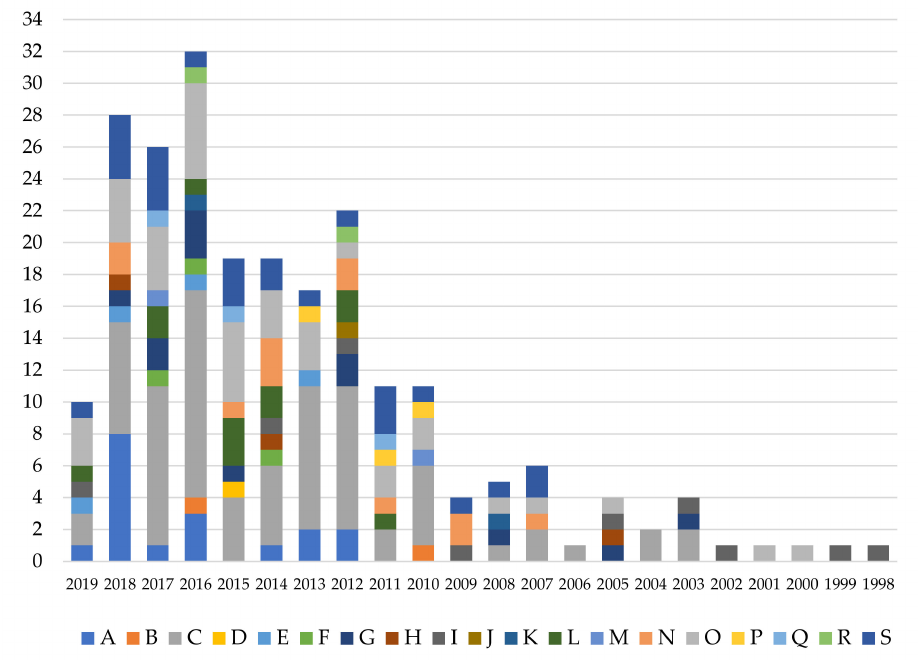
Figure 7. Number of studies classified by knowledge and year categories: Agriculture, forestry and fishing ( A ); Mining and quarrying ( B ); Manufacturing ( C ); Water supply; sewerage, waste management and remediation activities ( D ); Construction ( E ); Wholesale and retail trade; repair of motor vehicles and motorcycles ( F ); Transportation and storage ( G ); Accommodation and food service activities ( H ); Information and communication ( I ); Financial and insurances activities ( J ); Professional, scientific and technical activities ( K ); Administrative and support service activities ( L ); Public administration and defiance; compulsory social security ( M ); Education ( N ); Human health and social work activities ( O ); Arts, entertainment and recreation ( P ); Other service activities ( Q ); Activities of households as employers; undi ff erentiated goods and services producing activities of households for own use ( R ); and Other scopes not previously included ( S